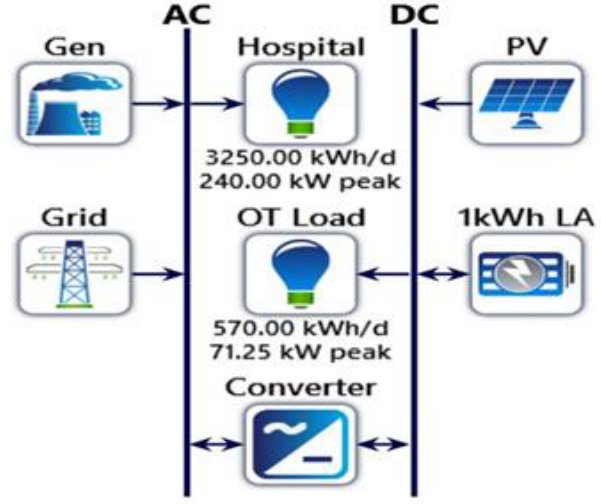
Figure 1. Schematic of the proposed model of the hybrid energy system.